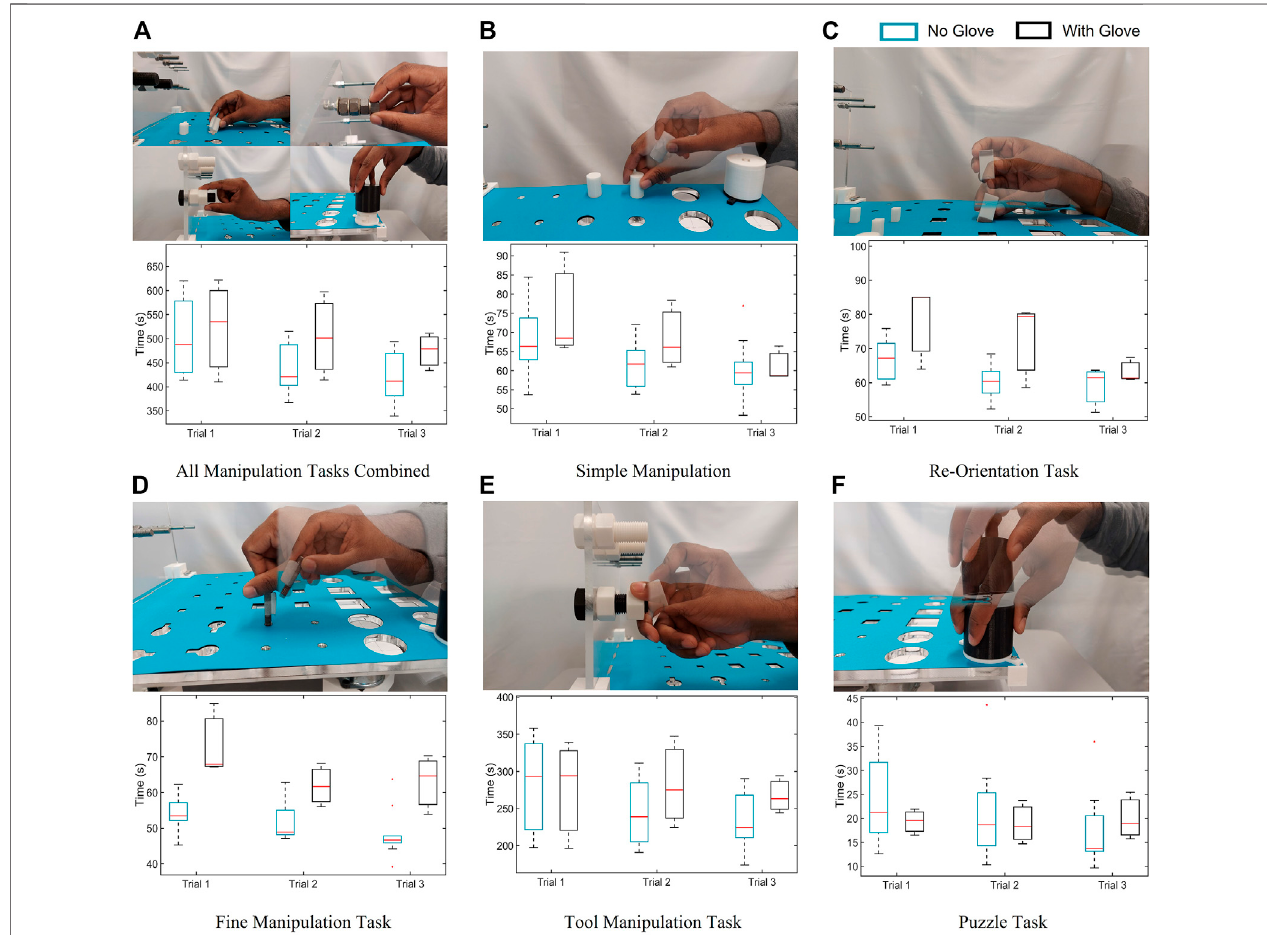
FIGURE 5 | The time taken by 10 subjects to complete various manipulation tasks across three trials with and without gloves is presented for: (A) all tasks combined, (B) simplemanipulationtasks, (C) re-orientationtasks, (D) fi nemanipulationtasks, (E) toolmanipulationtasks,and (F) puzzletasks.The fi gurealsopresentsa visual representation of the tasks from each of the fi ve different task